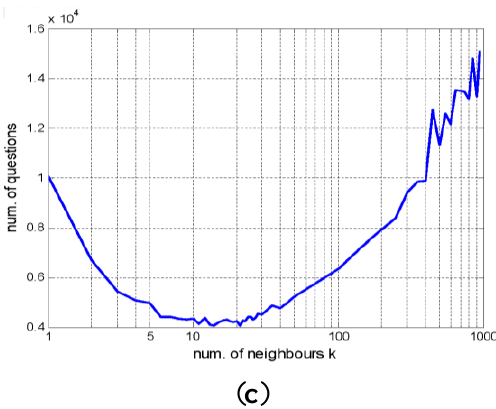
Figure 14. The effect of k on the initial k -NN graph. The curve shows the final number of queries for ASC as a function of k in the range of (1,1000): ( a ) Beijing; ( b ) WHU-RS; and ( c ) UCM.